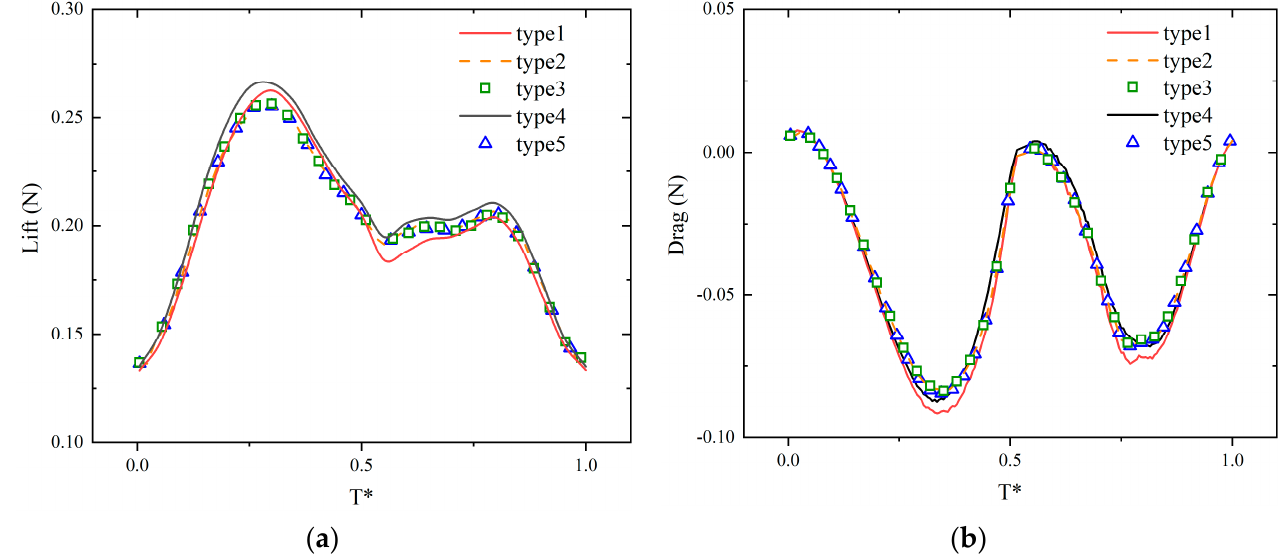
Figure 10. Comparison of different types of time steps and grid numbers. ( a ) Lift comparison. ( b ) Drag comparison. Table 3. Averaged thrust in time-convergence and grid-convergence tests.